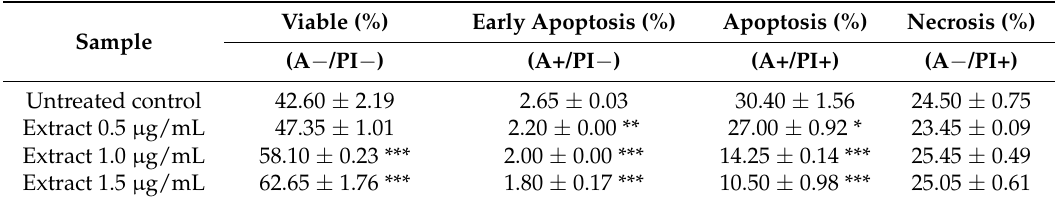
Table 5. Effect of A. harveyi leaf extract on viable, early apoptotic, apoptotic and necrotic sperm of bull frozen-thawed semen using the annexinV/PI